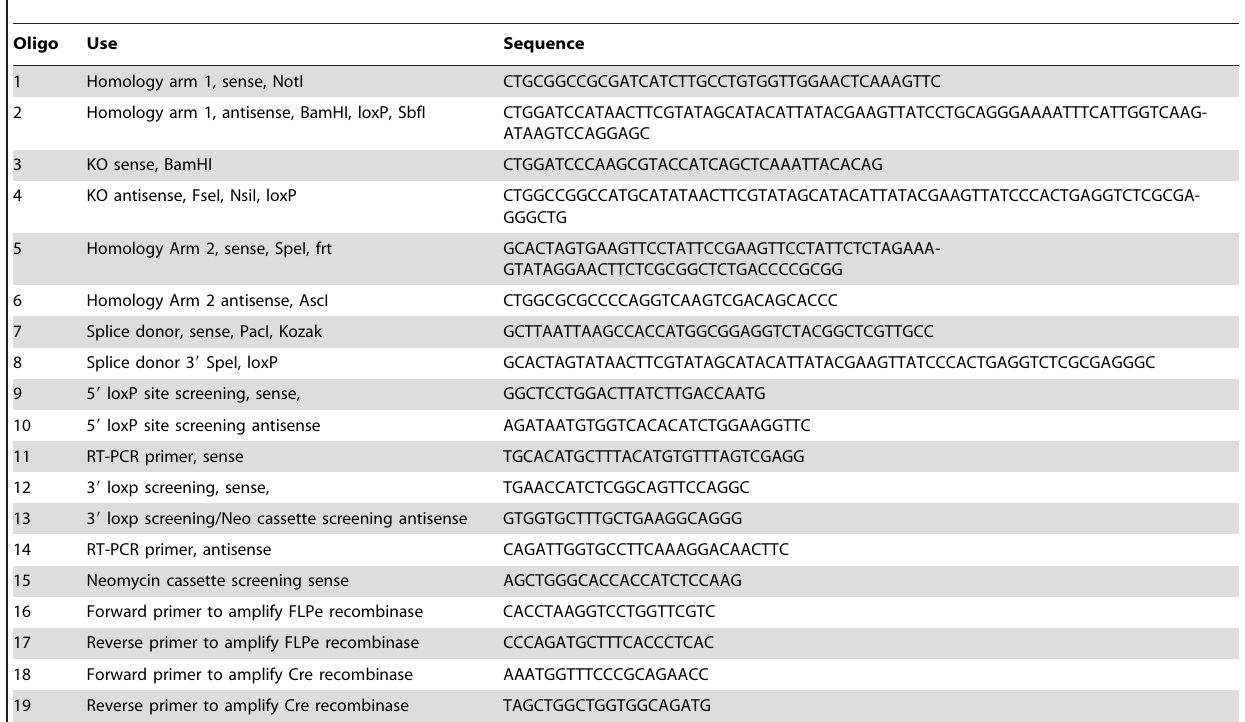
Table 1. Sequences of DNA primers for transgenic construct and for genotyping SLC7A5 transgenic mice.